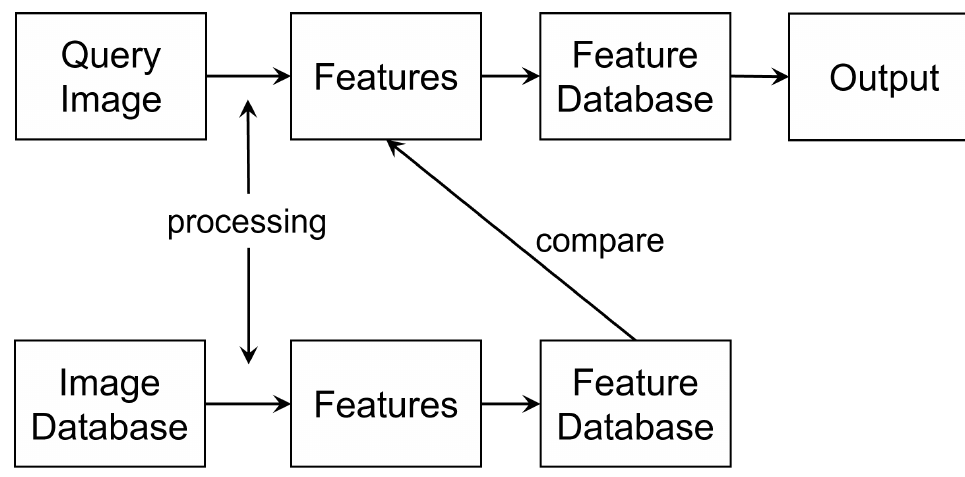
Figure 3. Flowchart for image